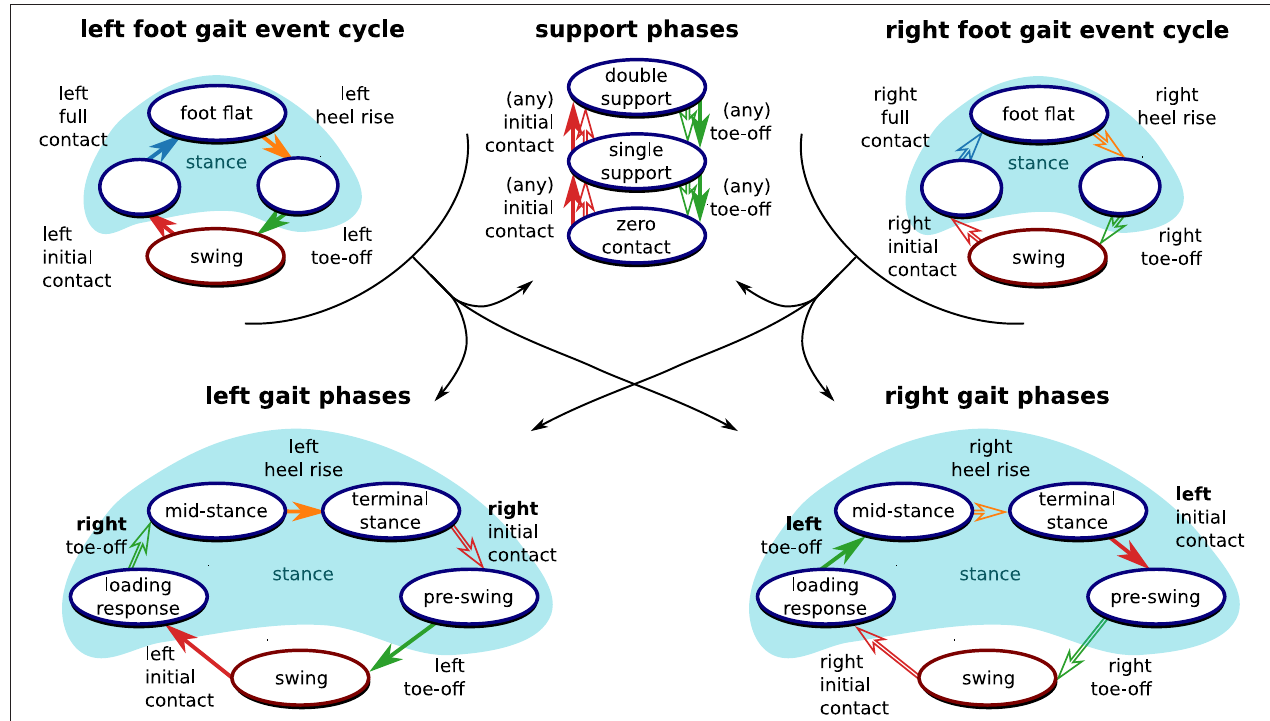
FIGURE 4 | Derivation of clinically relevant gait phases from the gait event cycles. Following standard literature (44), events from both the left foot (filled arrows) and the right root (outlined arrows) are necessary to define the gait phase of each foot. Furthermore, support phases based on the number of feet that are in contact with the ground can be defined based on the gait